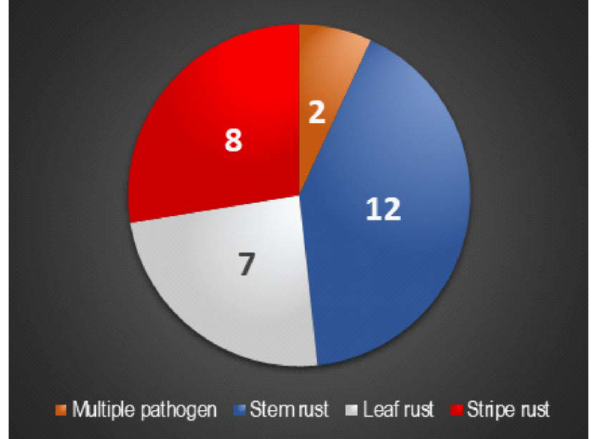
Figure 4: Targets of rust resistance genes screened for in the marker- assisted selection programme at CenGen. Molecular markers for target genes/QTL are obtained from the public domain and research articles, or from in-house mapping projects by CenGen and collaborators. These include simple sequence repeat (SSR), sequence-tagged site (STS), cleaved amplified polymorphic site (CAPS) and single nucleotide polymorphism (SNP) markers. Since 2013, the implementation and upgrade of KASP TM SNPLline TM instruments (LGC, UK) at CenGen greatly enhanced high-throughput capacity. The number of data points (calculated as the number of samples x number of markers tested per sample) that are generated annually continues to increase (Figure 5) despite a decrease in industry funding.